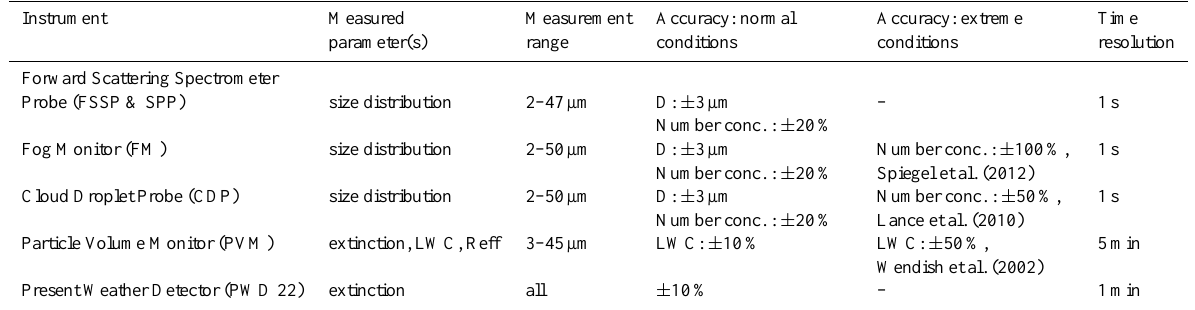
Table 2. Instrumental set-up during the ROSEA intercomparison campaign at the Puy-de-Dôme. Uncertainties in normal and extreme con- ditions are presented. Reff is the effective radius.